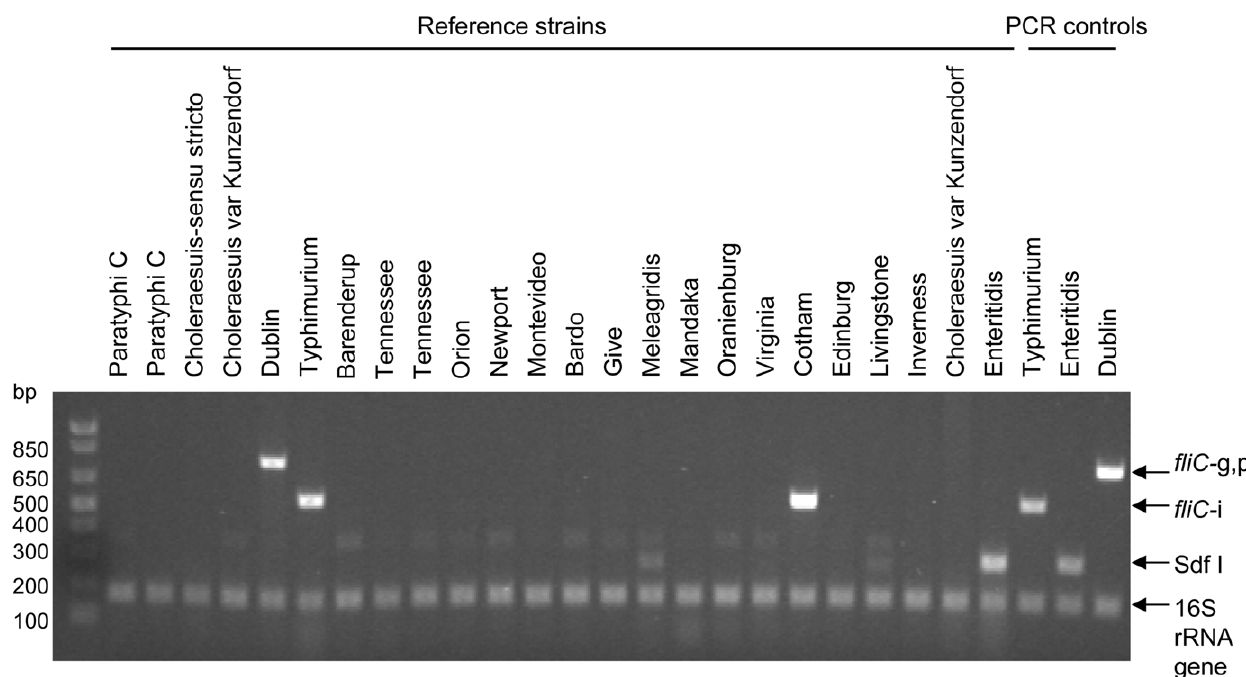
Figure 2. Blinded screening of 24 control strains by the fliC -i/ fliC -gp/Sdf I multiplex PCR. Reference strains consisted of one representative each of Salmonella Typhimurium, Salmonella Enteritidis and Salmonella Dublin and a range of negative control Salmonella strains of various serovars. PCR controls consisted of Salmonella Typhimurium 81.23500, Salmonella Enteritidis CVD SE, Salmonella Dublin 06-0707.